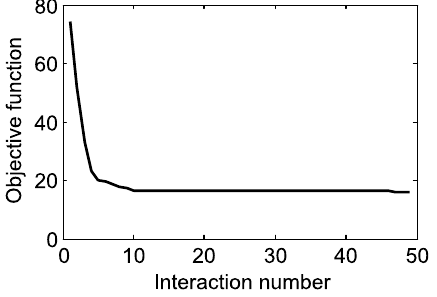
Fig. 8. Convergence history for the “L” shape plate. Fig. 9. Displacement amplitude versus frequency at the loading point of the “L” shape plate. Dot line represents bare plate, solid line represents plate with optimized PCLD layout and dot-dash line represents plate with PCLD fully